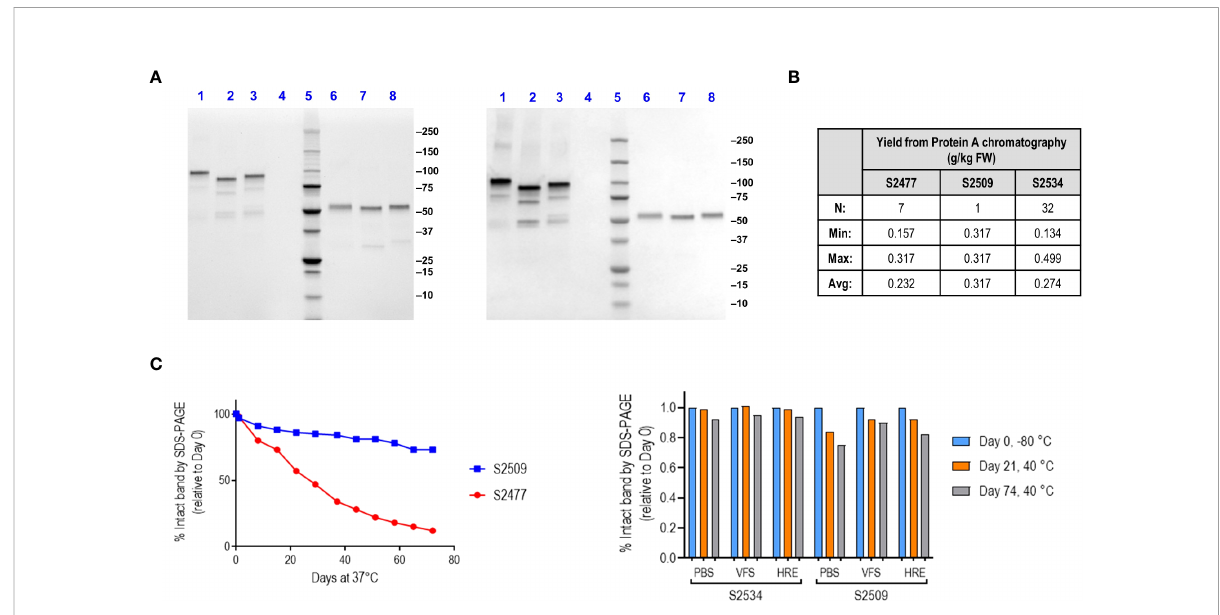
FIGURE 1 Production, characterization and stability of S2477 (FH*/Fc1), S2509 (Fc1/FH*) and S2534 (Fc3/FH*). (A). SDS-PAGE visualized with StainFree ( Left image ) and western blots probed with anti-human IgG ( Right image ) of Protein A puri fi ed S2477 (FH*/Fc1) (lanes 1 and 6), S2509 (Fc1/FH*) (lanes 2 & 7), and S2534 (Fc3/FH*) (lanes 3 and 8) under non-reducing (lanes 1-3) and reducing conditions (lanes 6-8). (B) . Yields of the fusion proteins. The Table shows that yields of S2477 (FH*/Fc1) and S2534 (Fc3/FH*) puri fi ed by Protein A chromatography were similar over multiple processing runs. Only one processing run was carried out for S2509 (Fc1/FH*) but the observed yield was within the ranges observed for S2477 and S2534. (C) Stability of S2509 and S2477. Left graph: S2509 (Fc1/FH*) was more stable than S2477 (FH*/Fc1) over 76 days at 37°C. Right graph: Replacing human IgG1 Fc (S2509) with IgG3 Fc (S2534) improves the stability of Fc/FH* in three different buffers over 74 days at 40°C. VFS, simulated vaginal fl uid that contains 77 mM NaCl, 7 mM lactic acid, 13 mM acetic acid, 25 mM glucose, 4 mM sodium acetate, 36 mM sodium lactate,